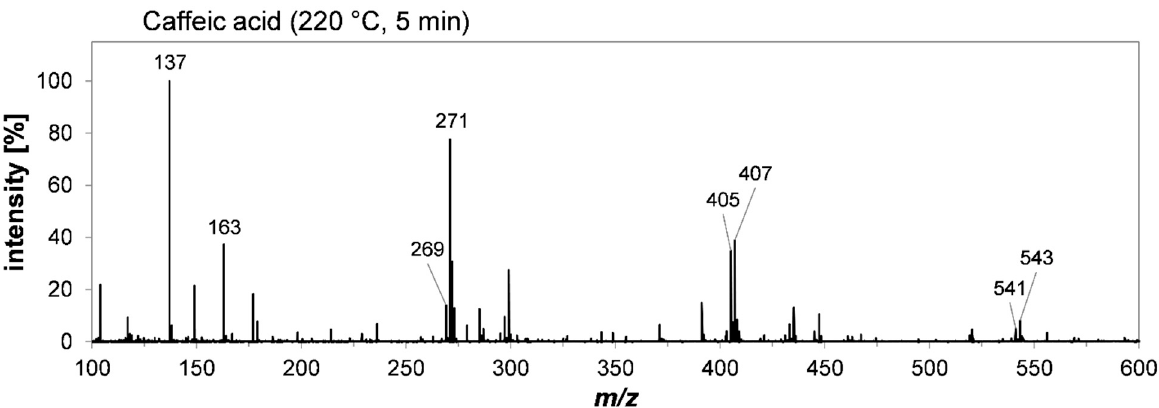
Figure 3. Non-enzymatic oligomerization of caffeic acid under roasting conditions (220 °C, 5 min). The high-resolution mass spectrum of the reaction mixture was modified by removing the signal of the solvent (dimer of ethyl acetate) and re-referencing the intensity of all signals accordingly. A scan spectrum of the solvent is attached and can be found in the supplementary material (Figure S1).